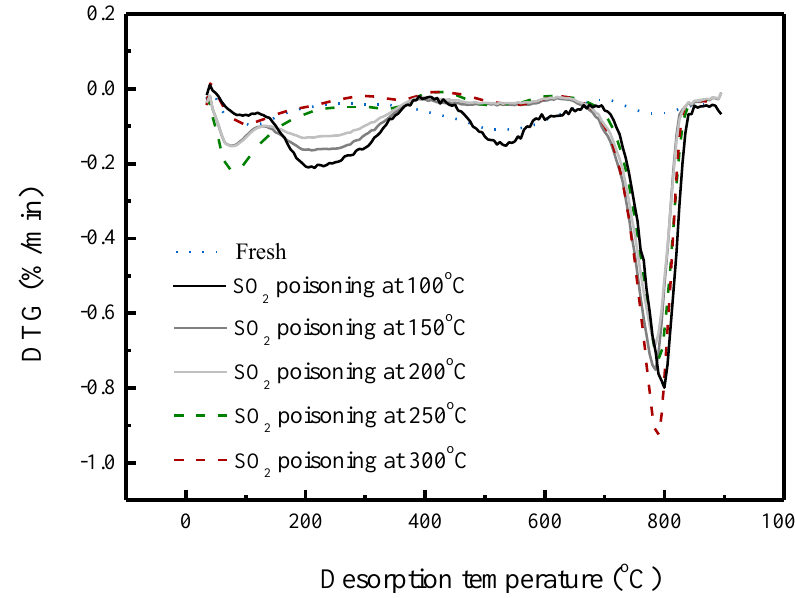
Figure 5. DTG spectra of fresh catalyst and catalysts poisoned at different reaction temperatures after 6 h poisoning time. 6 h poisoning